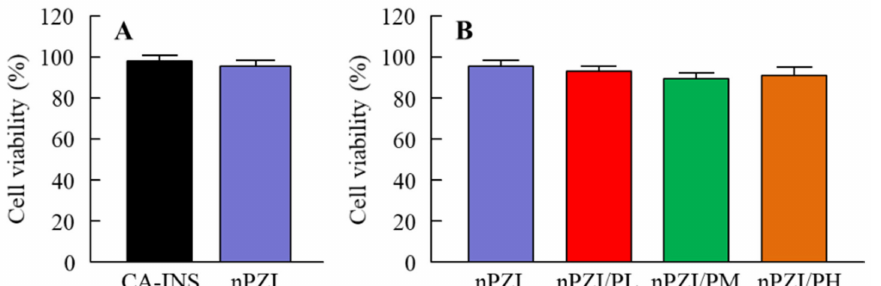
Figure 3. Corneal toxicity ( A , B ) in HCE-T cells treated with CA-INS, nPZI, nPZI/PL, nPZI/PM, or nPZI/PH. The compositions of the INS ophthalmic formulations are shown in Table 1. n = 8. Corneal toxicity was not observed for the nPZI and nPZI/P used in this study.